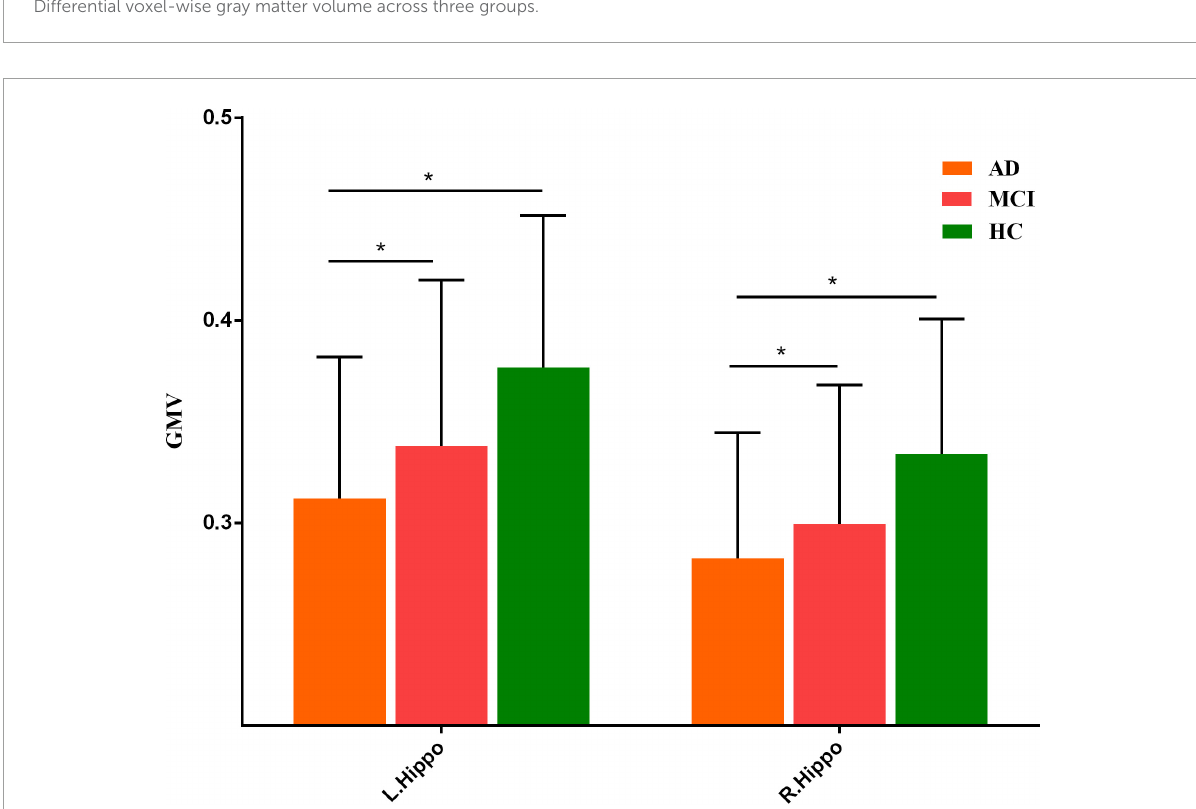
FIGURE2 Post hoc results of gray matter volume difference in bilateral hippocampus. “*” meant p value <